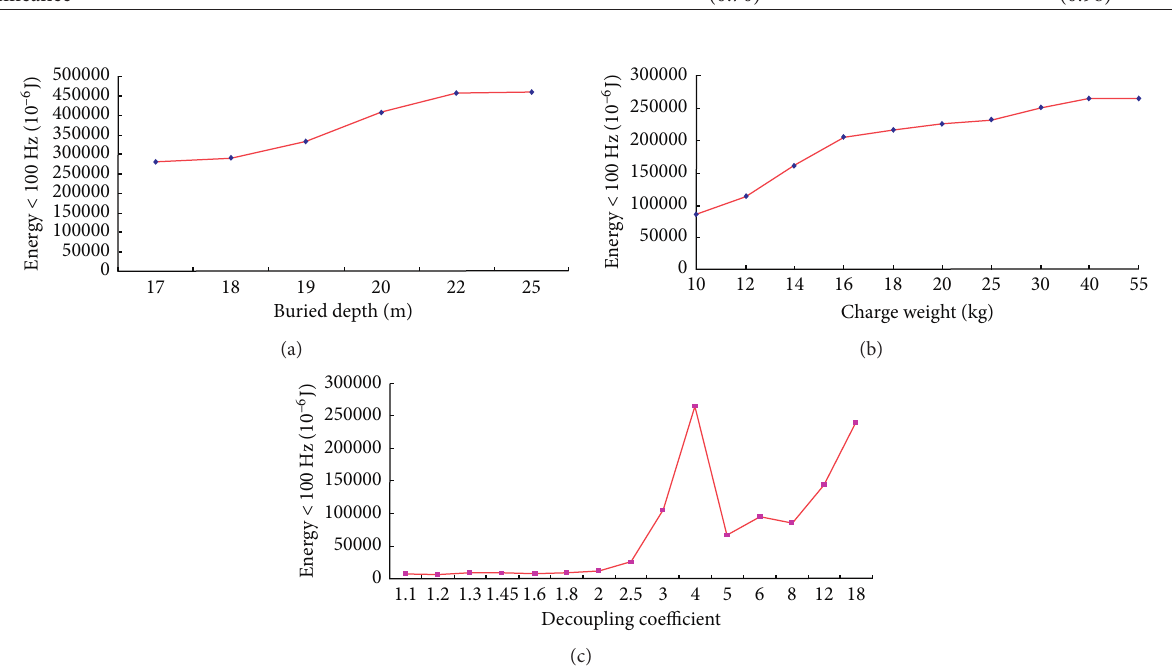
Figure 6: Variations in low-frequency energy of the seismic source wavelet according to different explosion parameters. (a) Buried depth. (b) Charge weight. (c) Decoupling coefficient. Data are the means of the values at the same collection point of 10 models.